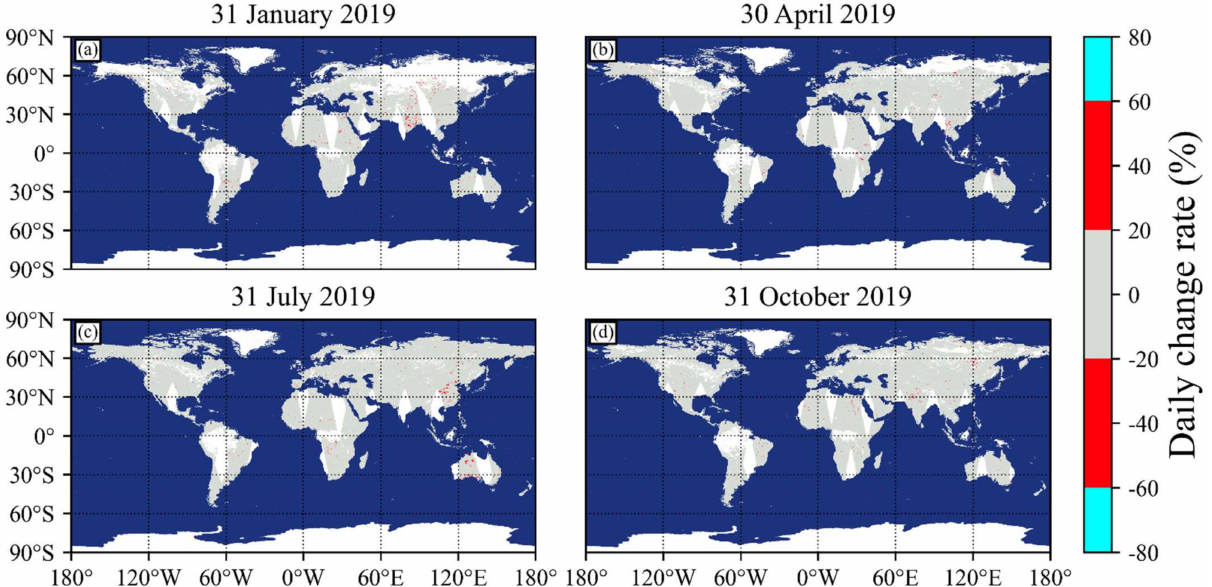
Figure 7. Soil moisture daily change rate on ( a ) 31 January, ( b ) 30 April, ( c ) 31 July and ( d ) 31 October of